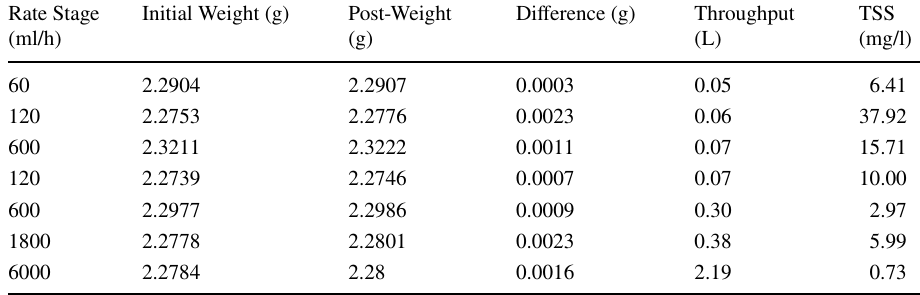
Table 12 Effluent total suspended solids for core flood 4